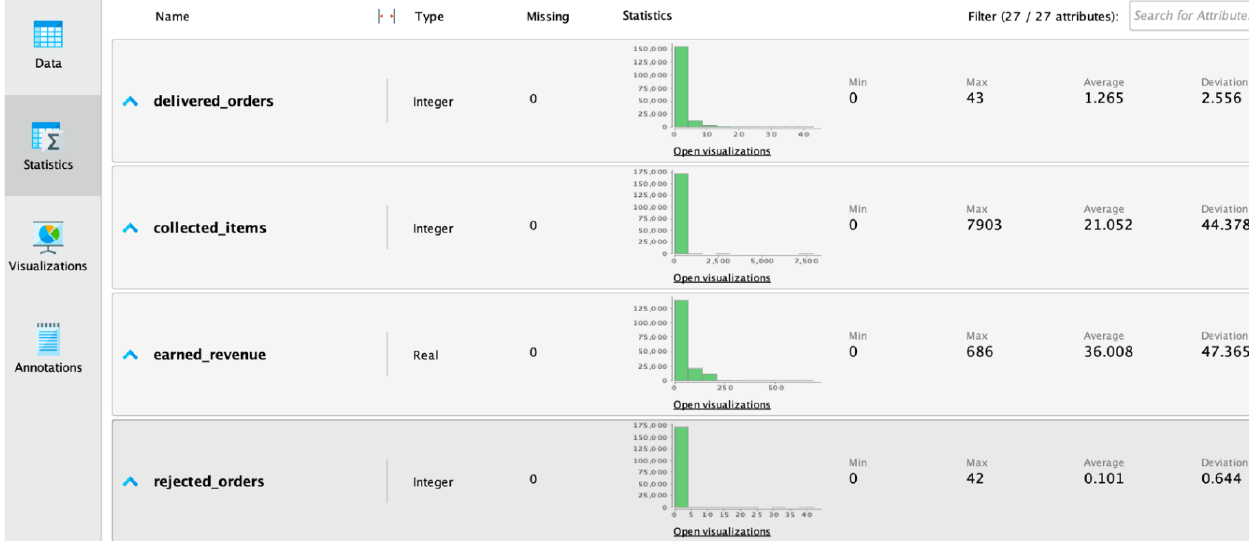
Figure 2. Snapshot of the statistics summary for the traditional approach using RapidMiner.